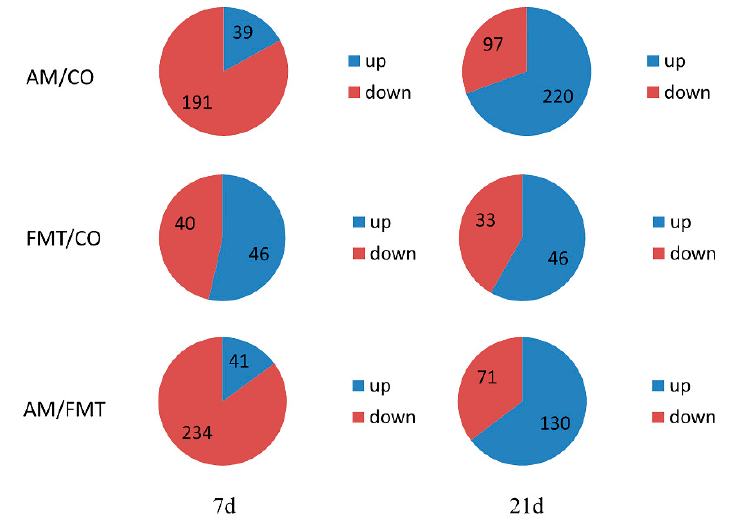
Figure 2. Numbers of the total differentially expressed genes as well as the up- and down-regulated genes in the ileum mucosa of pigs among the amoxicillin (AM), fecal microbiota transplantation (FMT), and control (CO) groups on days 7 and 21.